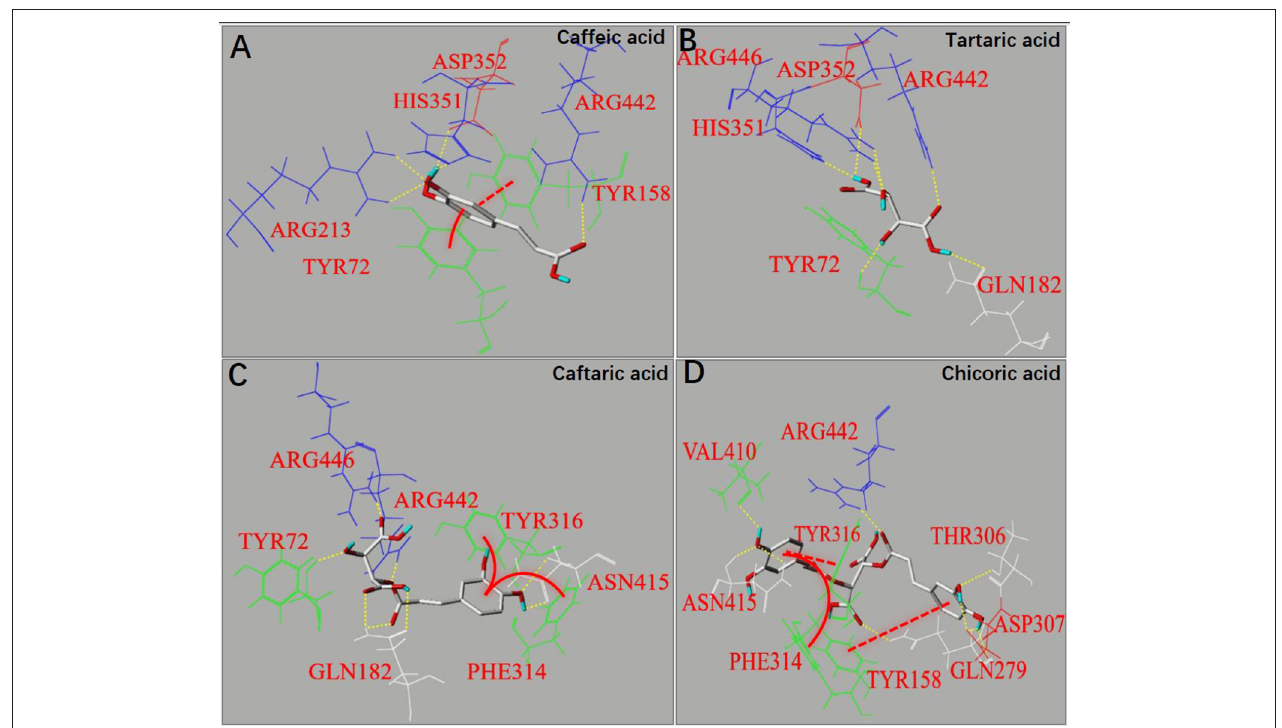
FIGURE 5 | The molecular docking for binding interactions of caffeic acid (A) , tartaric acid (B), caftaric acid (C) and chicoric acid (D) with α -glucosidase, respectively. The interaction forces involved hydrogen bonding (yellow dashed lines) and π - π hydrophobic forces, including parallel conjugations (red dashed lines) and vertical conjugations (red full